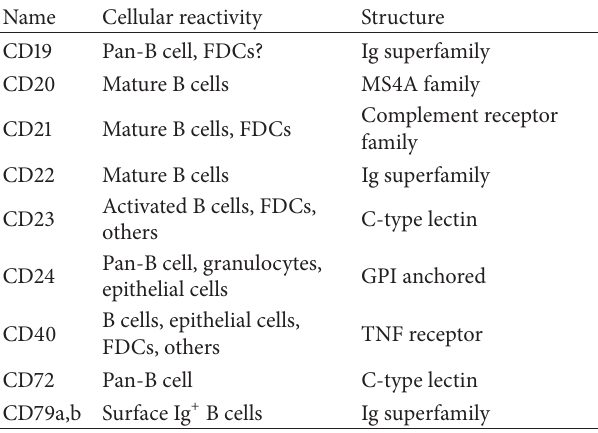
Table 2: Cell surface CD molecules that are preferentially expressed by B